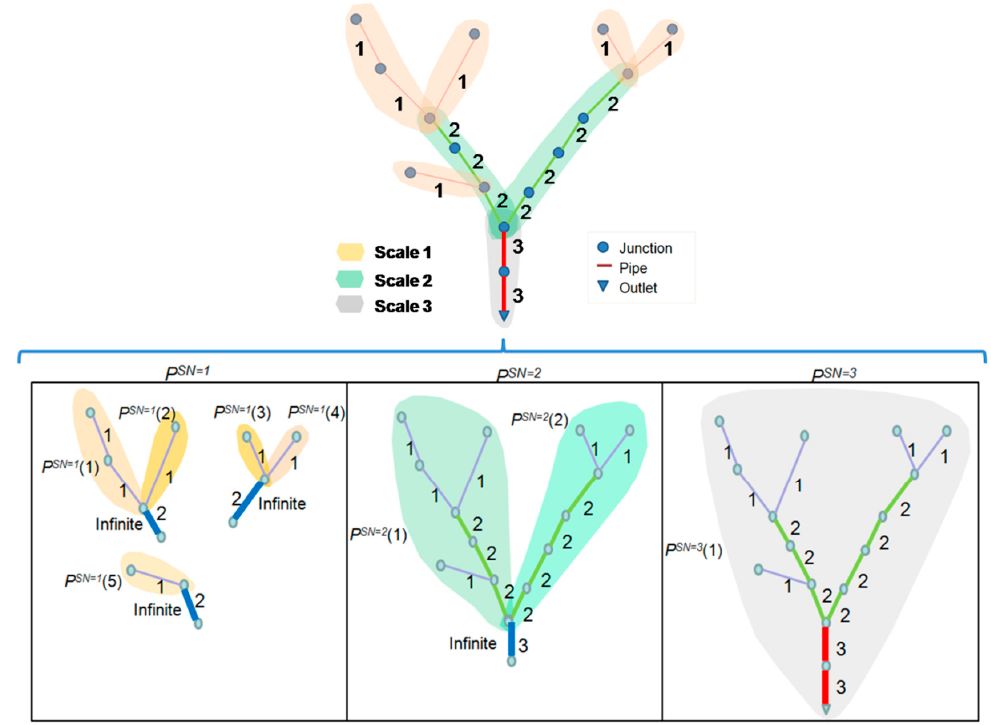
Figure 3. Decomposition of a small drainage network based on the Strahler number.